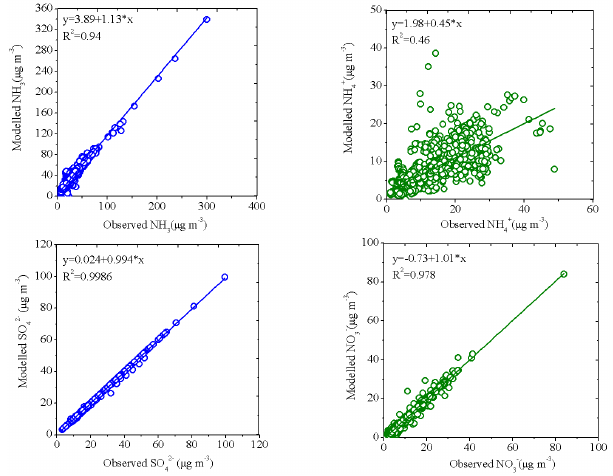
Figure 5. Observed and modelled concentrations of NH 3 , NH + SO 2 − , and NO − in summer 4 3